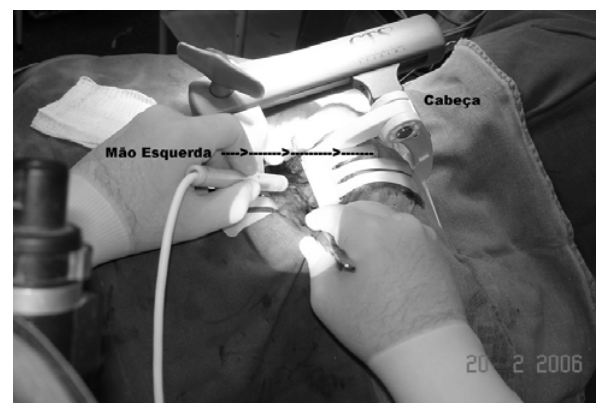
Fig. 6 - Posição ergonomicamente confortável para o cirurgião